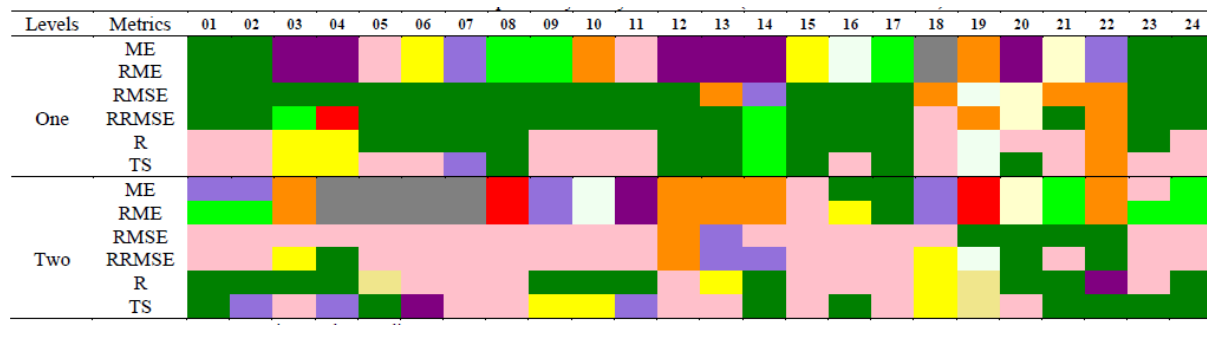
Note: MOD16A2 ignored according to Sect. 4.1. Table 13. Same as Table 6 but MOD16A2 replaced by the synthesized ET and based on Table